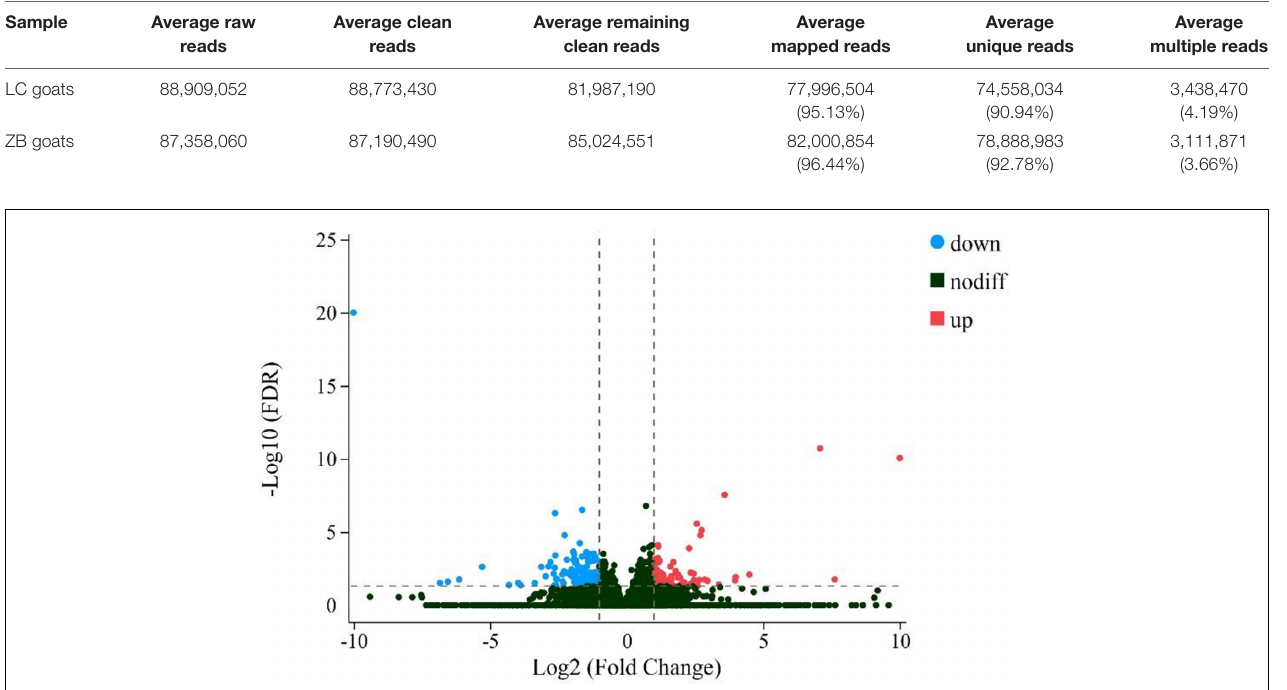
FIGURE 2 | Volcano plot comparing the change in gene expression of the LC goats and ZB goats. The red and blue dots represent the up-regulated and down-regulated genes in the Longissimus dorsi muscle tissues of ZB goats compared to the Longissimus dorsi muscle tissues of LC goats, respectively (FDR < 0.05). The black dots represent genes that are not significantly different in the two caprine breeds (FDR >